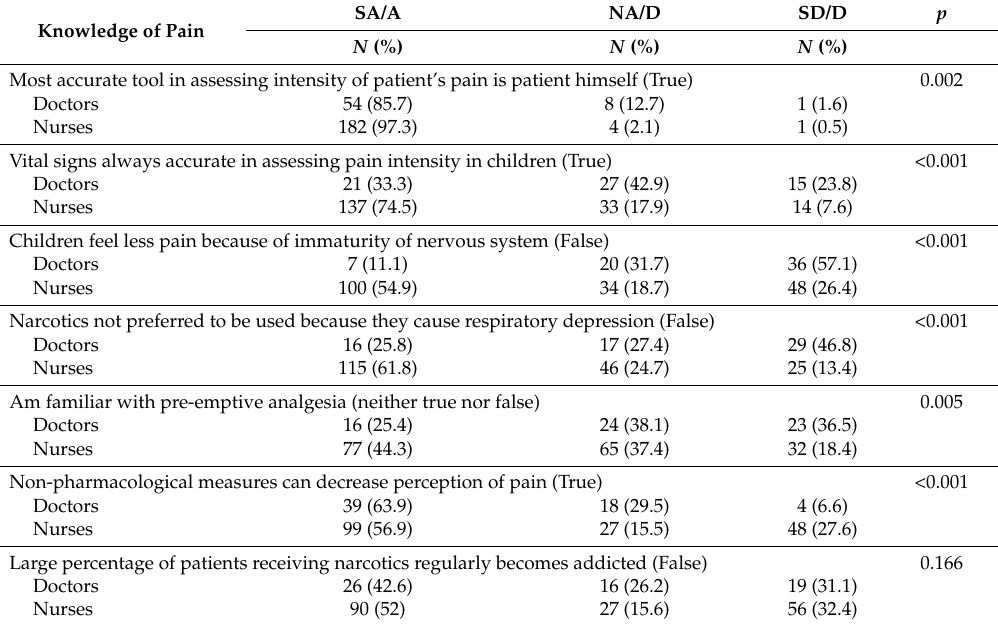
Table 3. Knowledge of pain among orthopedic doctors and nurses ( N = 253).